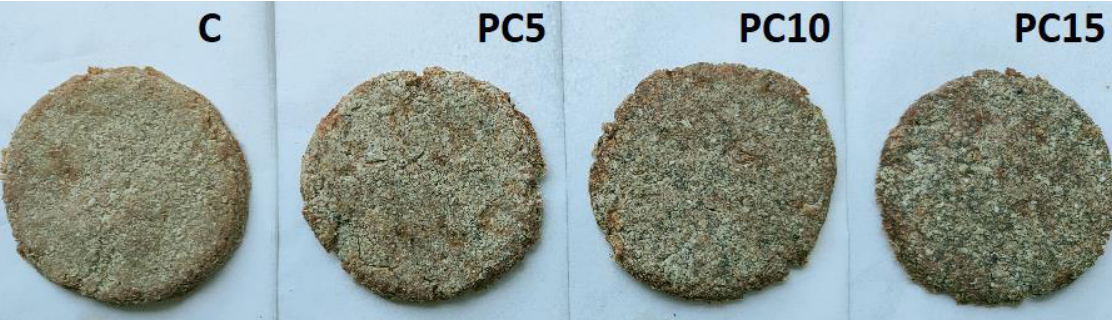
Figure 1. Exemplary pictures of the appearance of oatmeal cookies with poppy seed expeller added: C — control probe, PC5 — oatmeal cookies with 5% poppy seed expeller added; PC10 — oatmeal cookies with 10% poppy seed expeller added; PC15 — oatmeal cookies with 15% poppy seed expeller added.